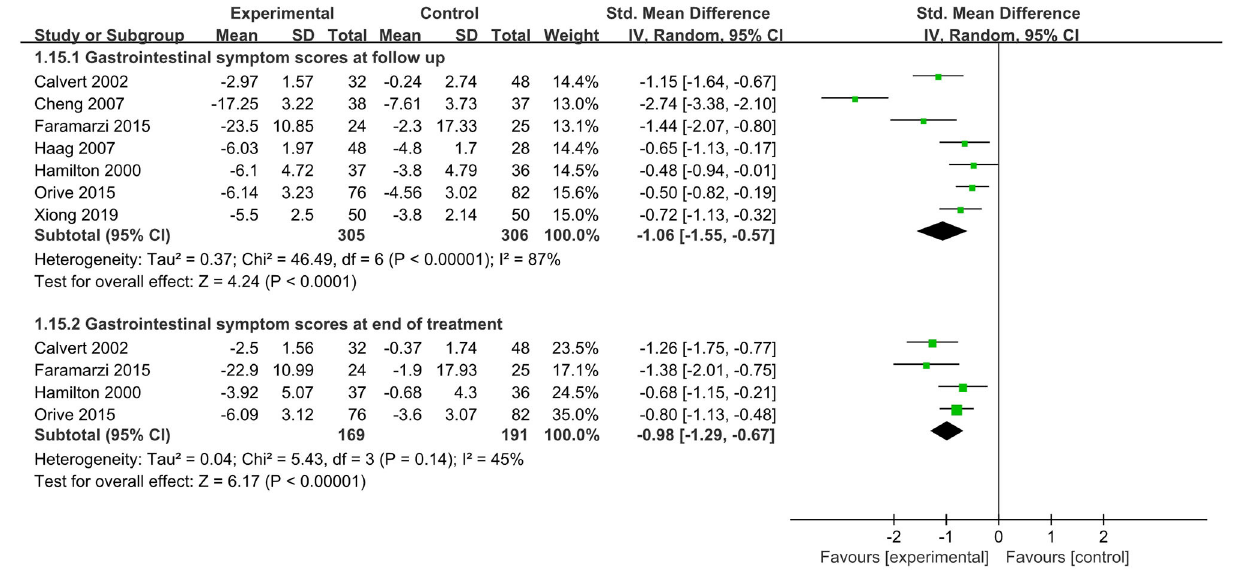
FIGURE 4 | Meta-analysis of the effect of Psychological interventions on gastrointestinal symptom scores. CI, confidence interval.